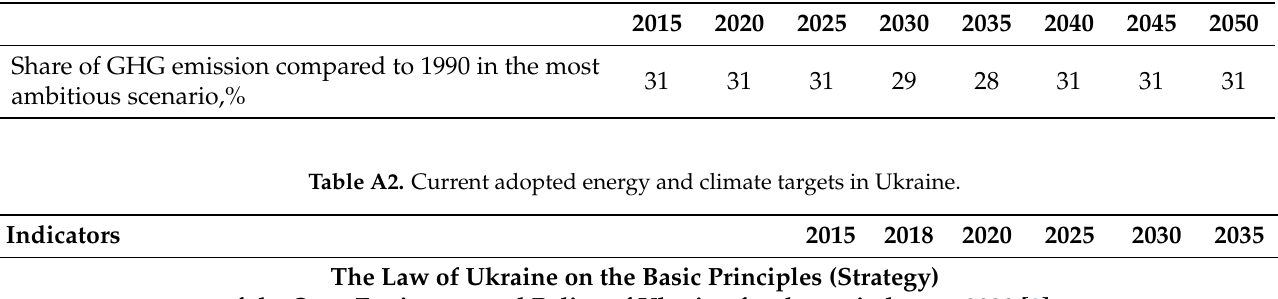
Table A1. Projections of GHG emissions in Energy and Industrial processes sectors in Ukraine 2050 Low-Emission Development Strategy [4].